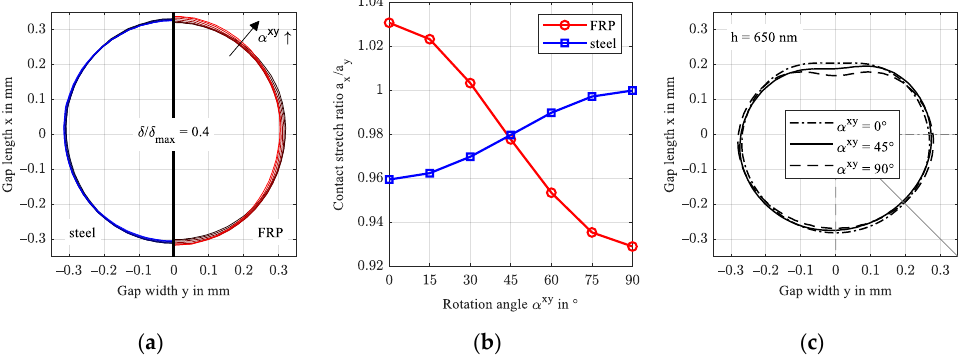
Figure 12. Normalized contact deformation of the steel and FRP surface for the increasing rotation angle 𝛼 𝑥𝑦 in the xy-plane ( a ), contact stretch ratio ( b ), and isocontour at a film thickness level of 650 nm ( c ).